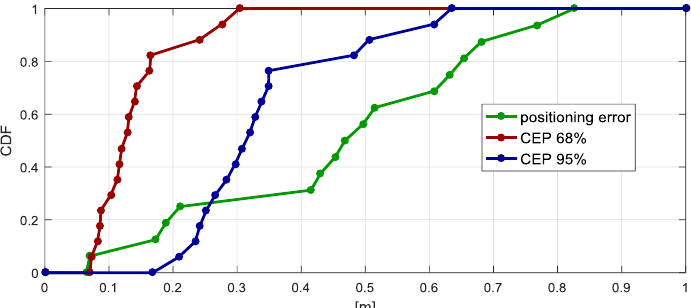
Figure 15. Empirical Cumulative Distribution Functions (CDF) of positioning errors and CEP coefficients.